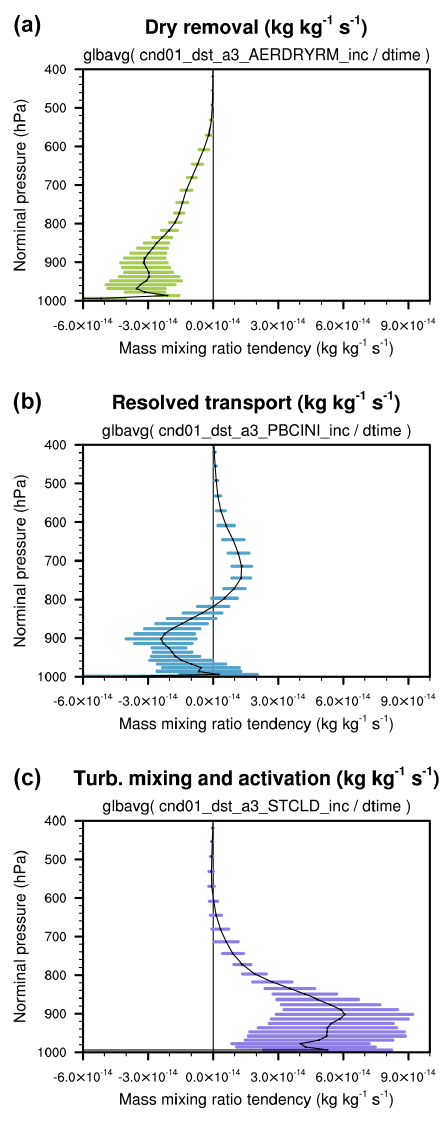
Figure 6. Globally averaged vertical profile of the coarse-mode dust mass mixing ratio tendencies (unit: kgkg − 1 s − 1 ) attributed to dry removal (a) , resolved transport (b) , and the turbulent mixing and activation of aerosol particles (c) . The black curves are monthly av- erages. The lengths of the horizontal bars correspond to twice the standard deviation of the daily averages. The expressions given be- low panel titles indicate how the global averages are calculated from the model’s output